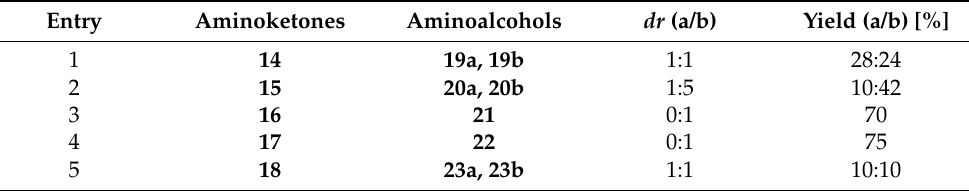
Table 3. Synthesis of aminoketones 14 – 18 via Mannich